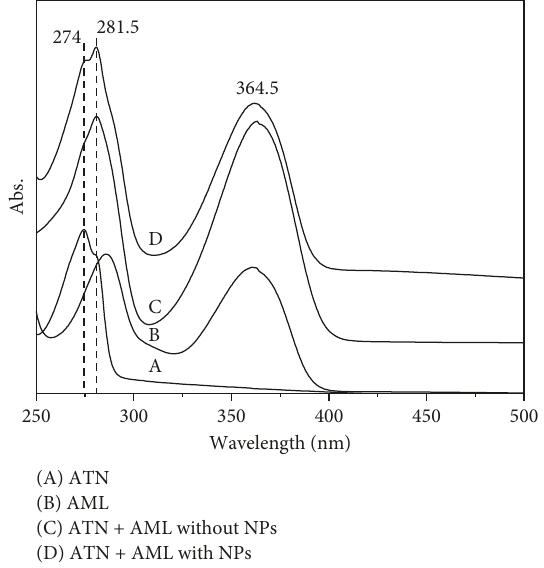
4 mol 1 ATN, (B) 10 L × · − − 1 KNO L 3 . · −